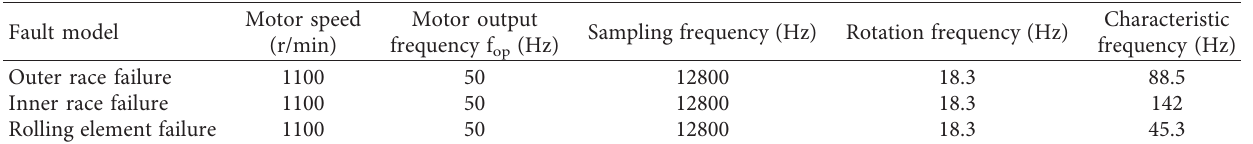
Table 2: Experimental parameters of faulty